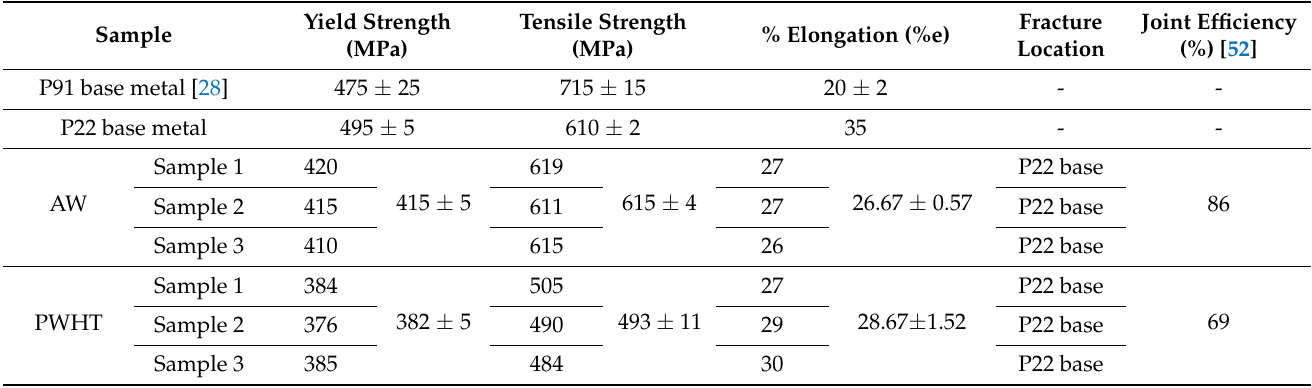
Table 3. Tensile test